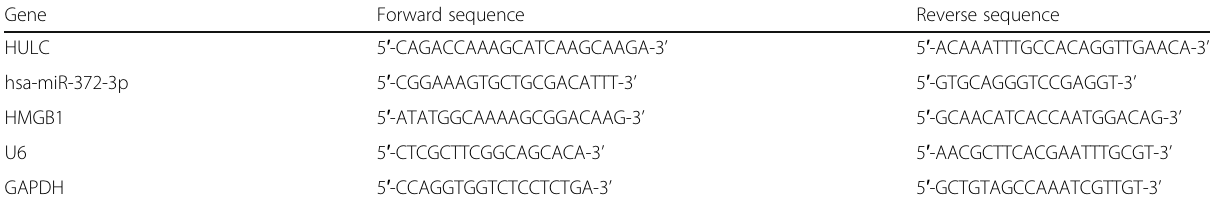
Table 1 Primer sequences for quantitative real-time PCR Gene Forward